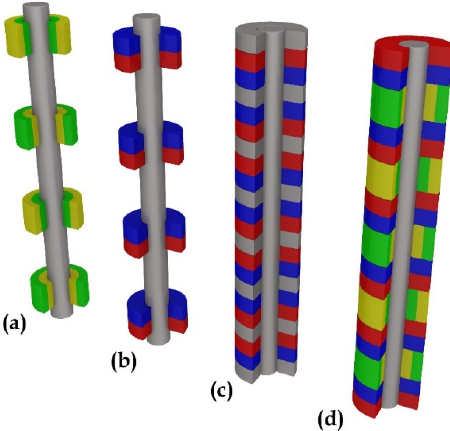
Figure 3. Di ff erent magnetization schemes: ( a ) radial, ( b ) axial, ( c ) Halbach, ( d )